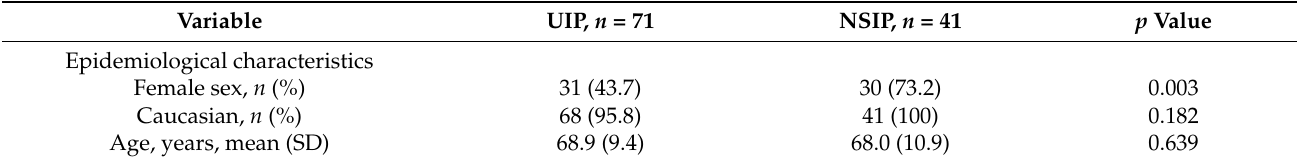
Table 2. Comparison of baseline characteristics between patients with RA-ILD according to radiological pattern (UIP and